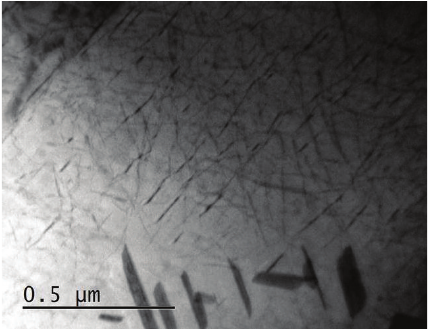
Figure 1: TEM BF picture of the microstructure of EL 21 + Al 2 O 3